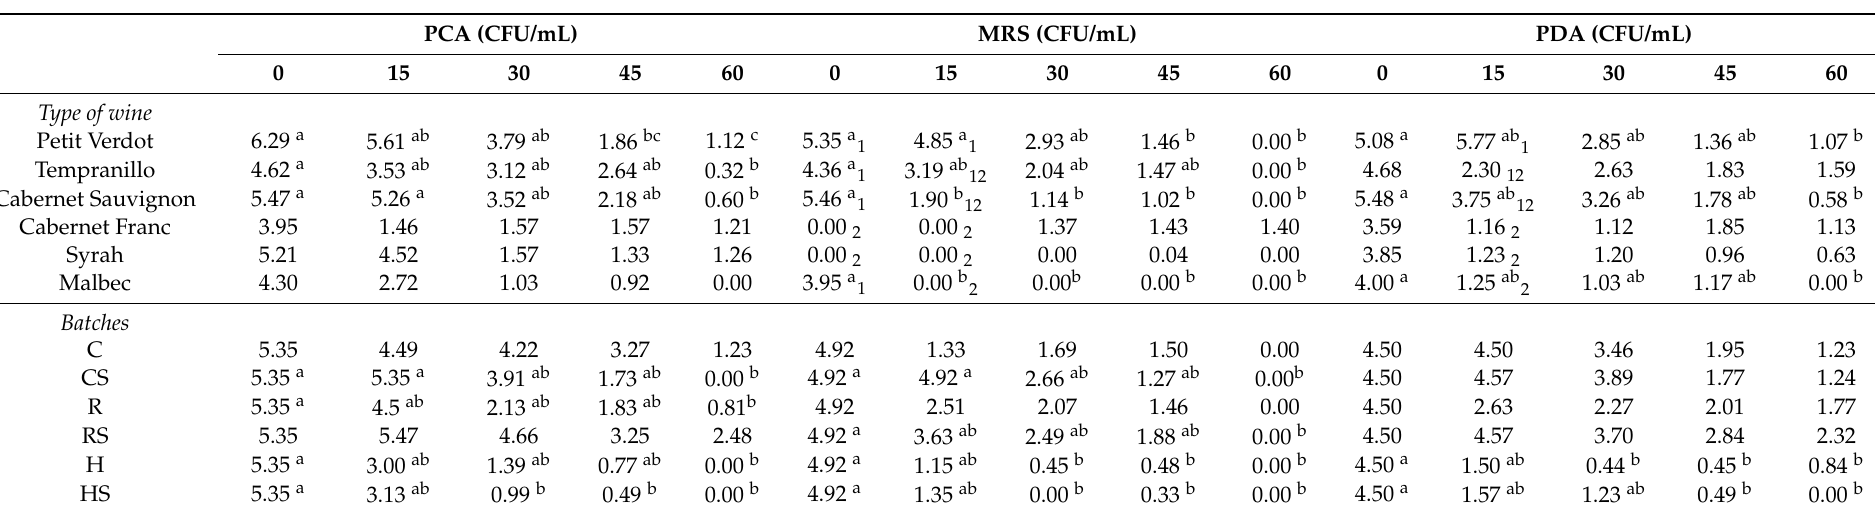
Table 4. Evolution of total aerobic bacteria (log CFU/g) in PCA medium, LAB (log CFU/g) in MRS medium and yeasts (log CFU/g) in PDA medium during monovarietal wine storage (0, 15, 30, 45 and 60 days). (C: control batch, CS: control batch with sulfur dioxide; R: batch of scratch, RS: batch of scratch plus sulfur dioxide, H: batch of grape skin and HS: batch of grape skin plus sulfur